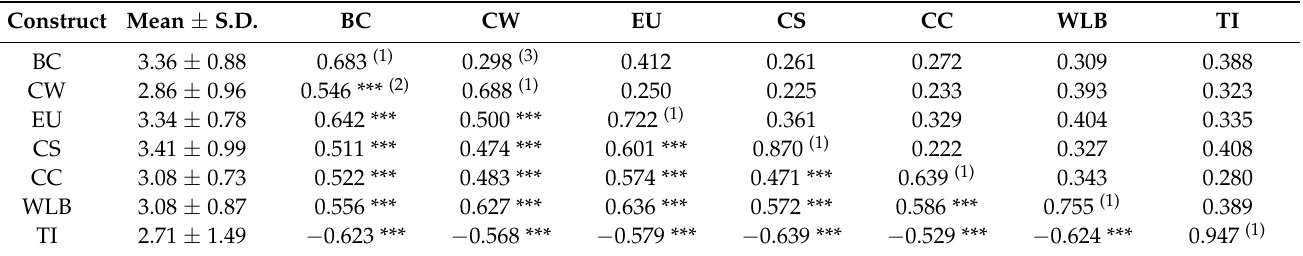
Table 3. Correlation analysis and discriminant validity